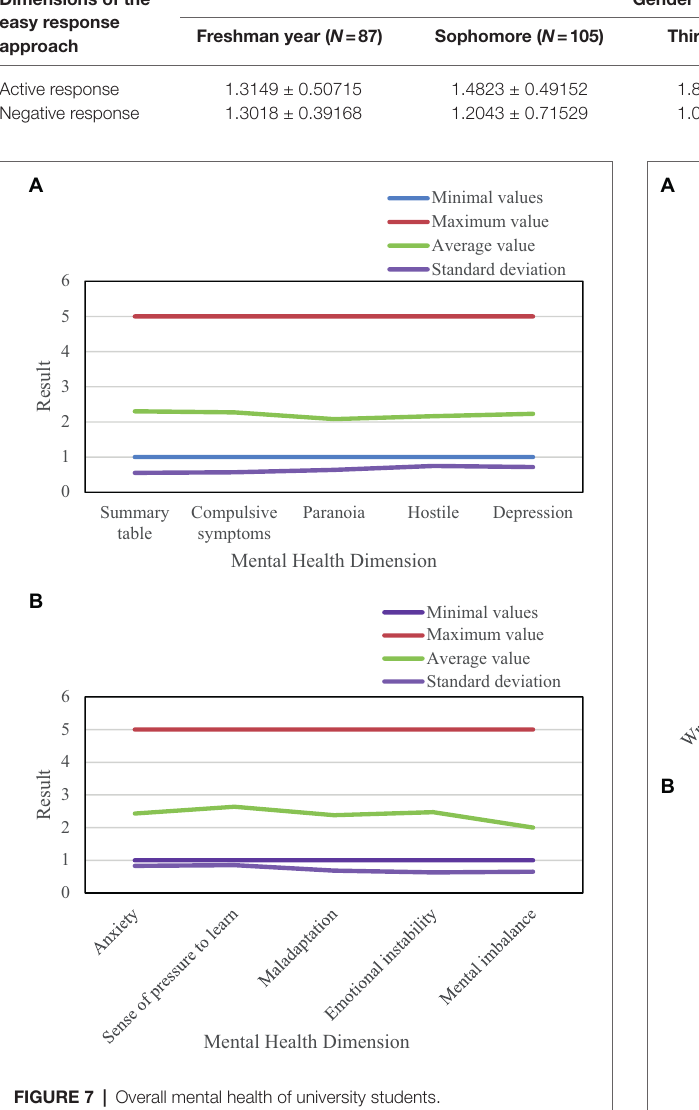
FIGURE 7 | Overall mental health of university students.